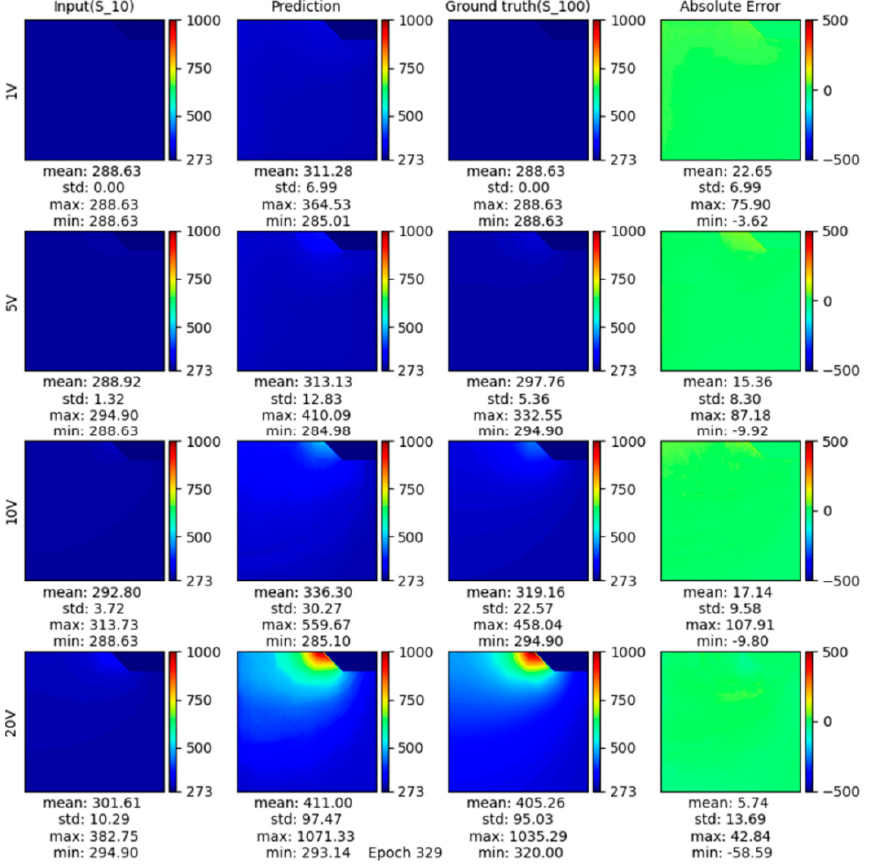
Figure 5. Deep learning provides temperature predictions on the SCB region at 10 µs at 1 V, 5 V, 10 V, and 20 V. The first column is input at a different voltage at 1 µs. The second column is output prediction by the DL model at different voltages at 10 µs, the third column is ground truth, and the fourth column is the absolute error about ground truth and prediction.